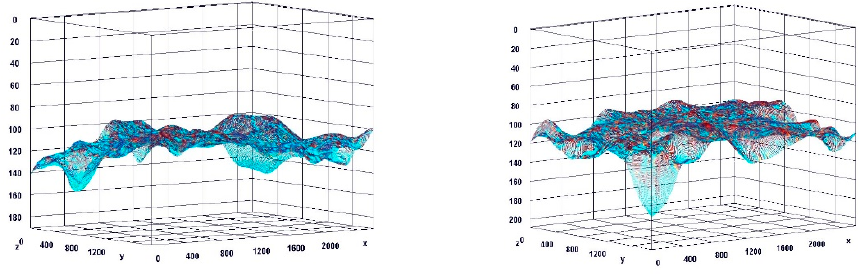
Figure 19. Visualization of the differences in collagen concentration before and after treatment.